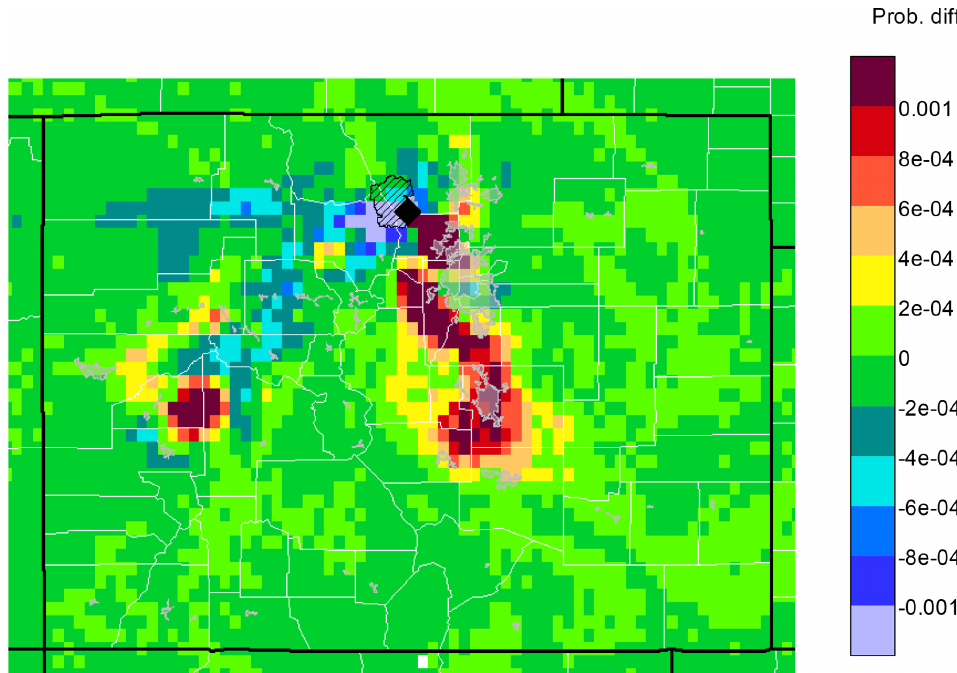
Figure 10. Differences between upwind transport during hours of 90th percentile or higher mixing ratios and average conditions during the study (HRT − ORT) for O 3 . Warm colors indicate areas that were more likely than average to be upwind during the 2 days prior to a high-mixing-ratio measurement at ROMO-LP. Cool colors indicate areas that were less likely to be upwind, while areas in green had similar likelihoods of being upwind during average and high-mixing-ratio hours. Table 2. Summary of high-O 3 events where at least 1h exceeded 70ppb. Timing of the exceedance and the average peak concentration for both the Longs Peak and Trail Ridge monitoring sites are also included. Times shown are local. ROMO-LP ROMO-TR hours exceeding average for i - to hours exceeding average for 70ppb exceedance n -pentane 70ppb